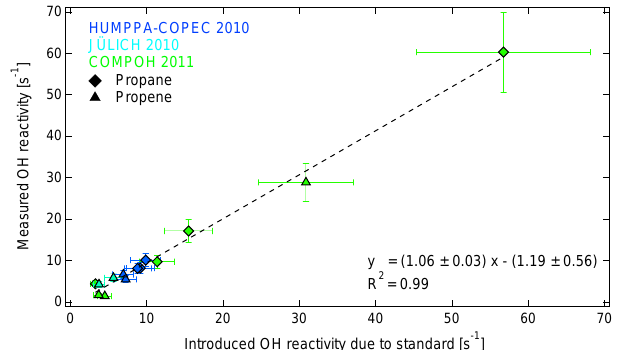
Fig. 1. Standard tests with propane and propene at different days for the HUMPPA-COPEC campaign (summer 2010), experiments in J¨ulich (autumn 2010) and the COMPOH campaign in Paris (spring 2011). Given is a linear fit, with slope and the quality of the fit.